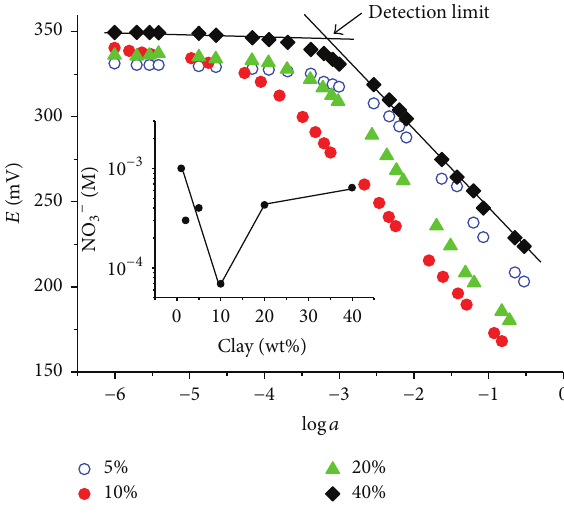
Figure 6: Potentiometric response to nitrate of ISE based on chitosan-clay composite membranes with different clay concentra- tions. Insert shows dependence of detection limit of ISE on the concentration of clay in membranes.